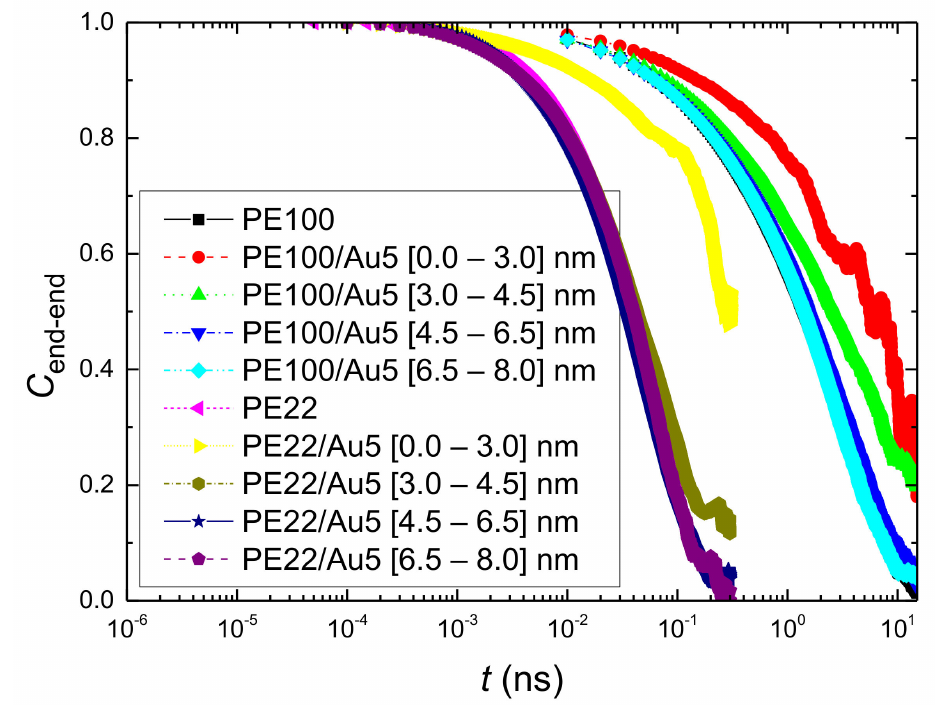
Figure A6. Time ACF of the end-to-end vector of PE chains, C end-end ( t ), as a function of time for PE22/Au5 and PE100/Au5 systems. C end-end ( t ) values for the PE22/Au5 and PE100/Au5 systems, for various spherical shells are